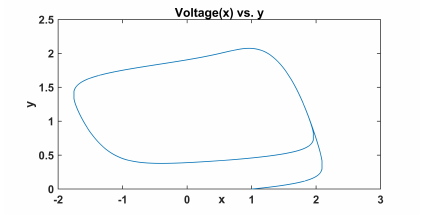
Figure 18. Recovery variable (right) with a constant external current value, I(t) = 4 µ A / cm 2 , a = 0.8 , b = 0.7 & c = 3